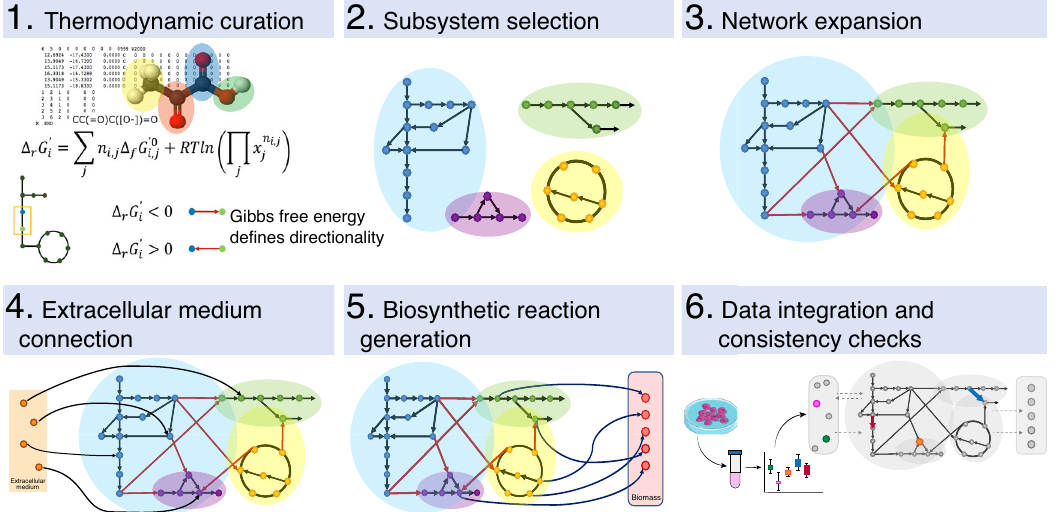
Fig. 1 redHUMAN work fl ow. (1) Thermodynamic curation: the Gibbs free energy of compounds and reactions are estimated and used to de fi ne the reaction directionality. (2) Subsystem selection: the subsystems relevant for the study are selected. (3) Network expansion: the initial subsystems are connected using reactions from the GEM to generate a core network. (4) Extracellular medium connection: the pathways that connect the extracellular medium components to the core network are identi fi ed. (5) Biosynthetic reaction generation: the pathways required to produce the biomass building blocks are classi fi ed. (6) Data integration and consistency checks: experimental values are integrated and the model is veri fi ed through consistency